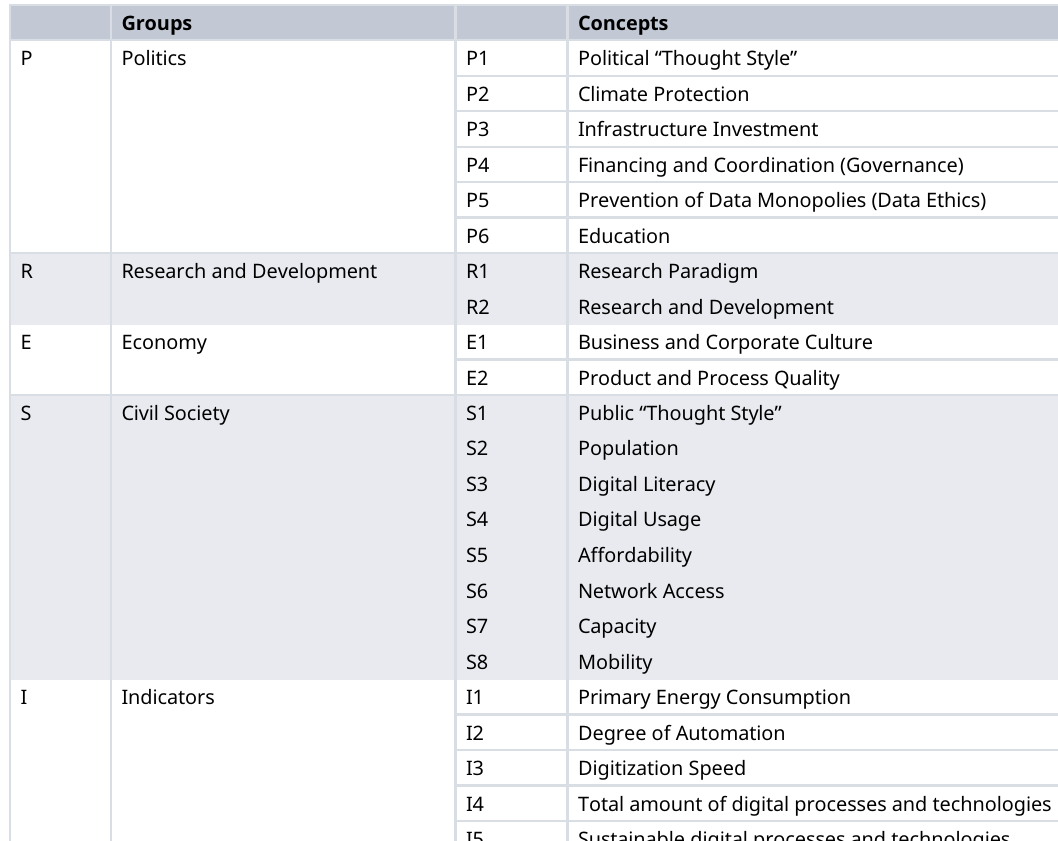
Table 8. Clarified concepts and